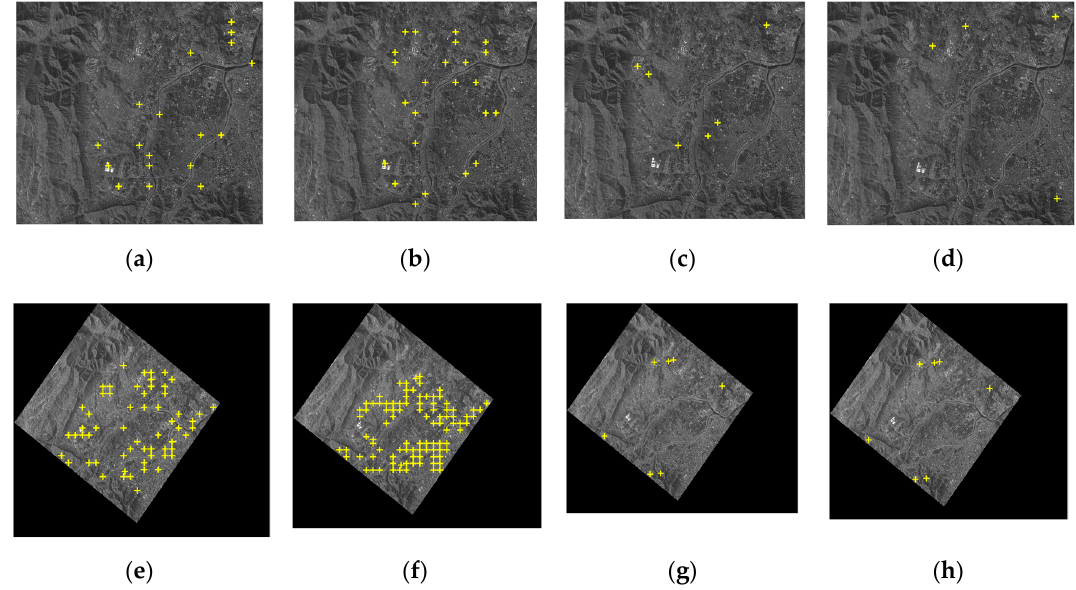
Figure 13. Visual expression of the extracted conjugate points overlaid with K3A-4099 image (template size: 500 × 500 pixels): ( a ) PC, ( b ) MI, ( c ) SURF, and ( d ) HARRIS–FREAK applied to the original image, and ( e ) PC, ( f ) MI, ( g ) SURF, and ( h ) HARRIS–FREAK applied to the coarse epipolar image.